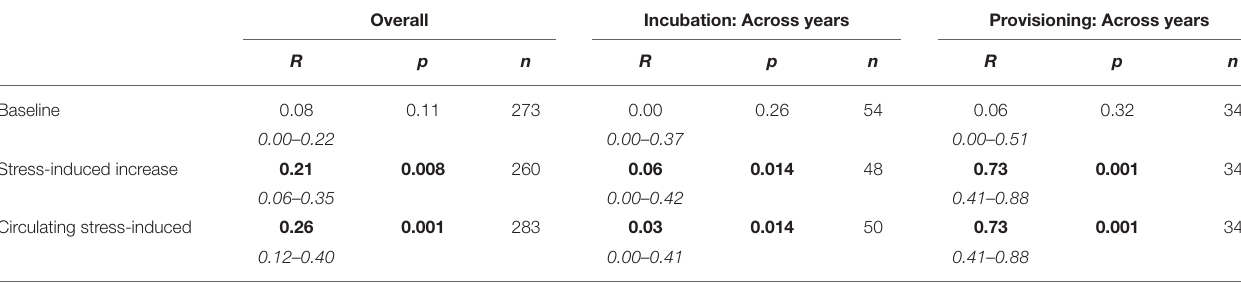
TABLE 5 | Glucocorticoid repeatability in female tree swallows. Overall Incubation: Across years Provisioning: Across